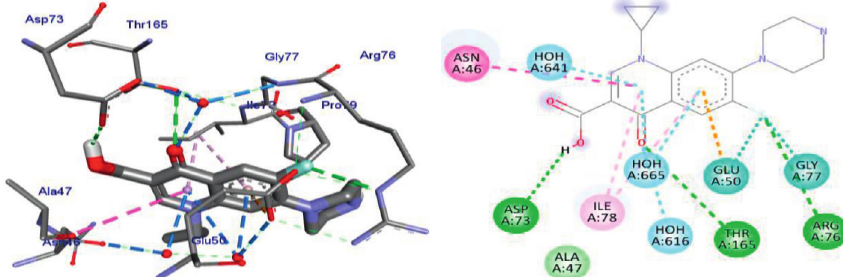
Figure 6: The binding interactions of ciprofloxacin against E. coli DNA gyrase B (PDB ID: